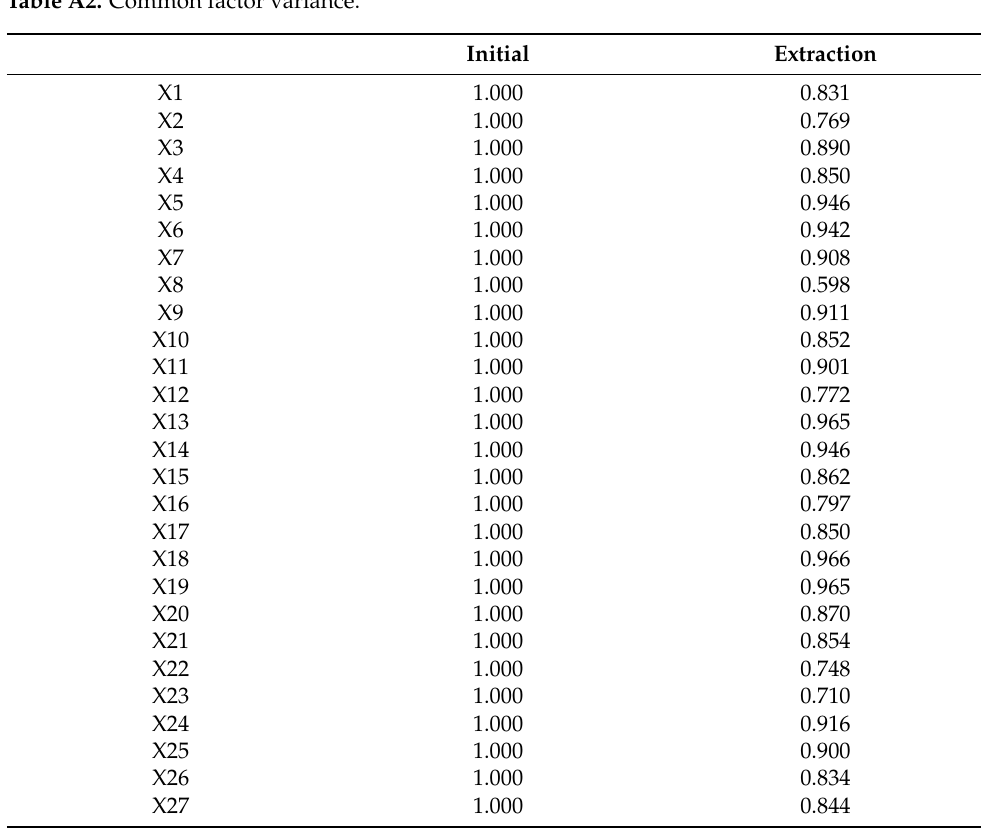
Table A2. Common factor variance.